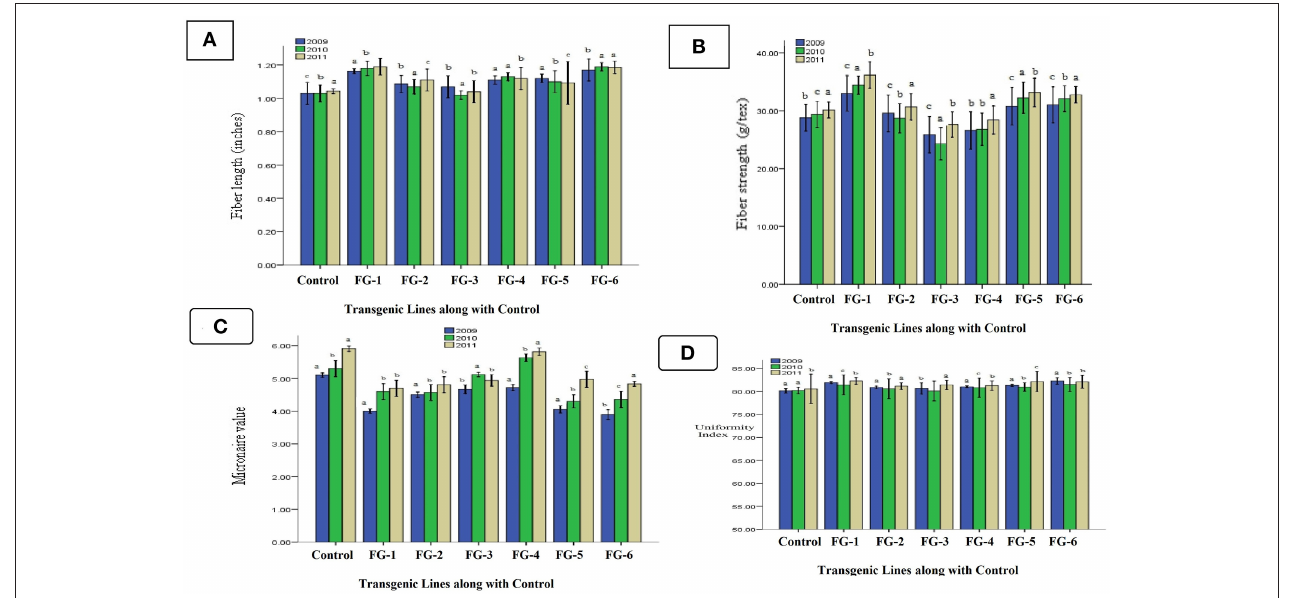
FIGURE 7 | Comparison of fiber length, fiber strength, fiber micronaire value, and fiber uniformity index of transgenic cotton plants with control (T0, T1, and T2): fiber length (A) , fiber strength (B) , fiber micronaire value (C) , and fiber uniformity index (D) of different transgenic cotton plants T 0 , T 1 , and T 2 in generations of 2009, 2010, and 2011, blue color represent fiber analysis at T0 generation, green color indicated fiber analysis at T1 generation, brown color highlight fiber analysis at T2 generation. Note: Bar Determined the Standard Error.